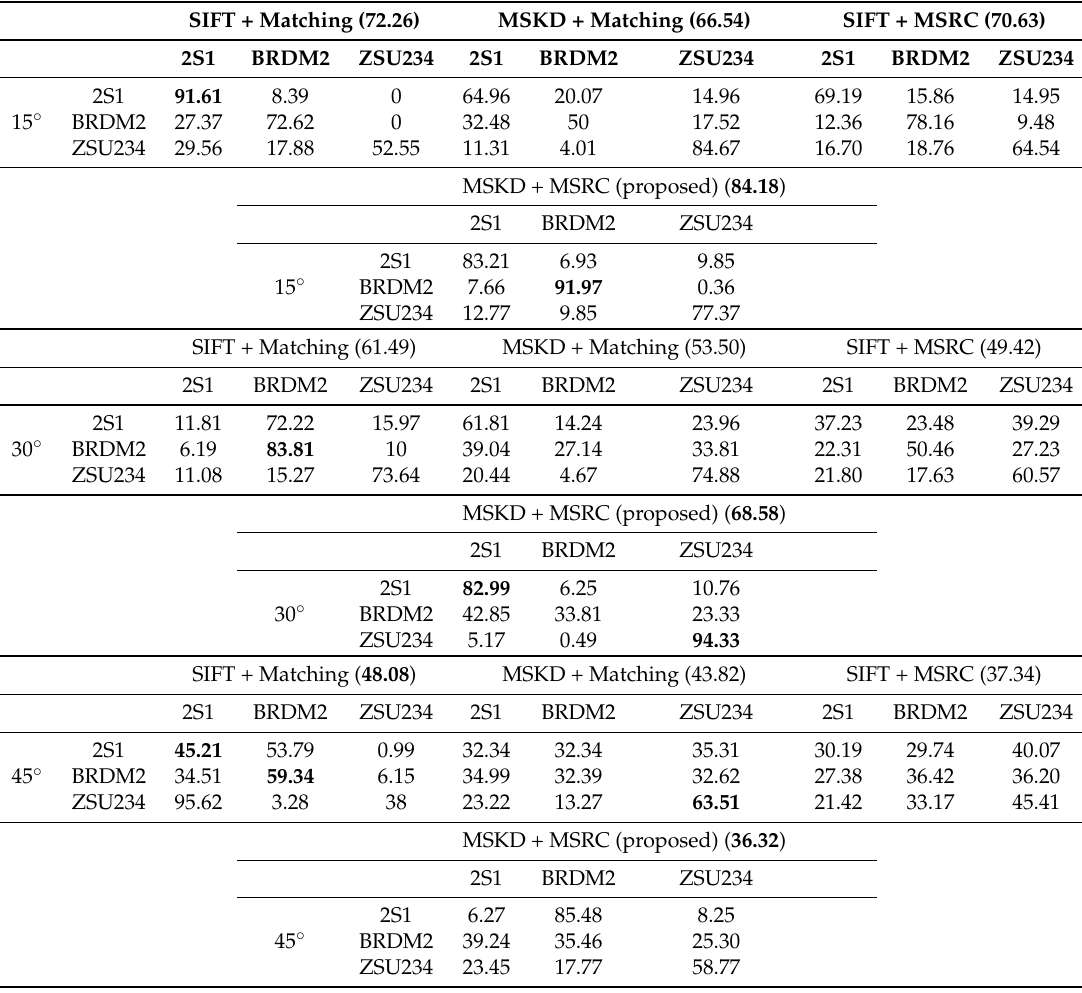
Table 8. Comparison between the confusion matrix of different methods (%) on MSTAR dataset under EOC-2 (depression